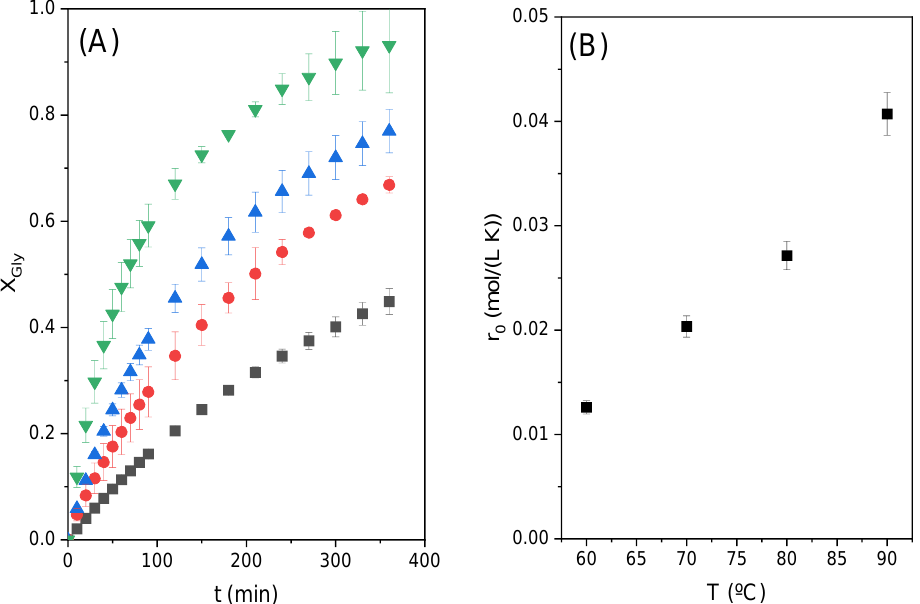
Figure 5. ( A ) Effect of the temperature in the transesterification reaction of Gly with CE with 3% catalyst loading and a CE/Gly molar ratio of 2. In this subfigure ◼ represents 60 °C; ⚫ 70°C; 80°C; and 90 °C. ( B ) Variation of the initial reaction rate with the different studied temperatures.